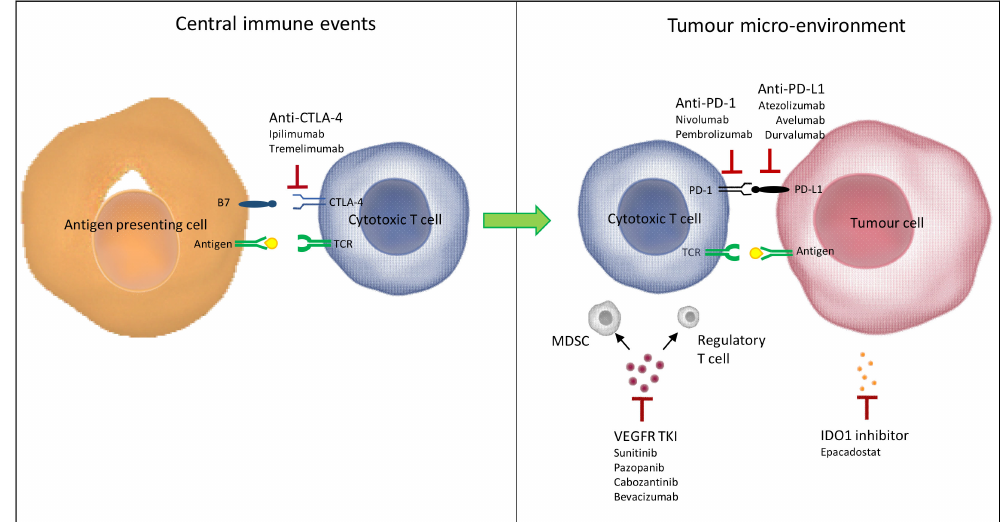
Figure 2. Rationale for combining immune checkpoint inhibitors with antiangiogenic drugs, anti-tumor immune response modulation adapted from Amin et al. Frontiers in Oncology. 2019. TCR, T cell receptor; MDSC, myeloid derived suppressor cells; VEGF, vascular endothelial growth factor; PD-1, programmed death 1; PD-L1, programmed death ligand 1; CTLA 4, cytotoxic T lymphocyte antigen